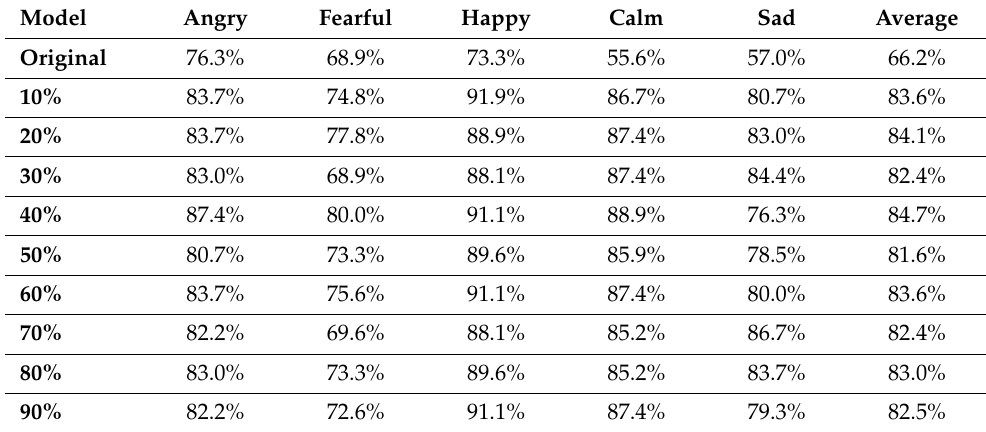
Table 2. Comparison of original method and rotating